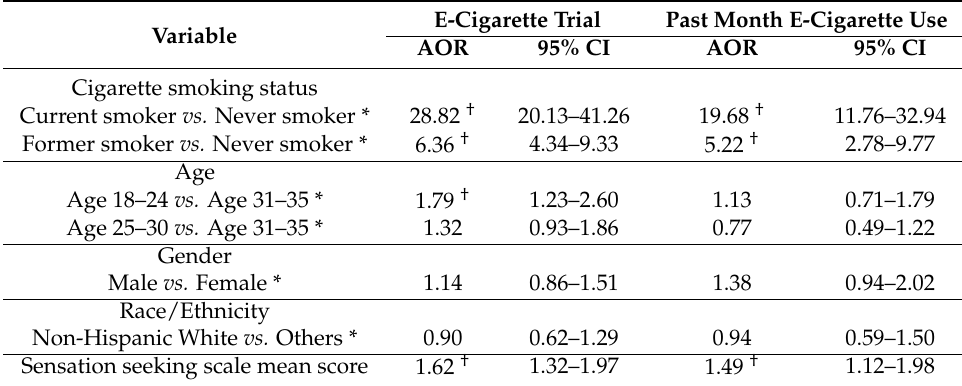
Table 1. Logistic regression analysis of electronic cigarette trial and current use among 4740 young